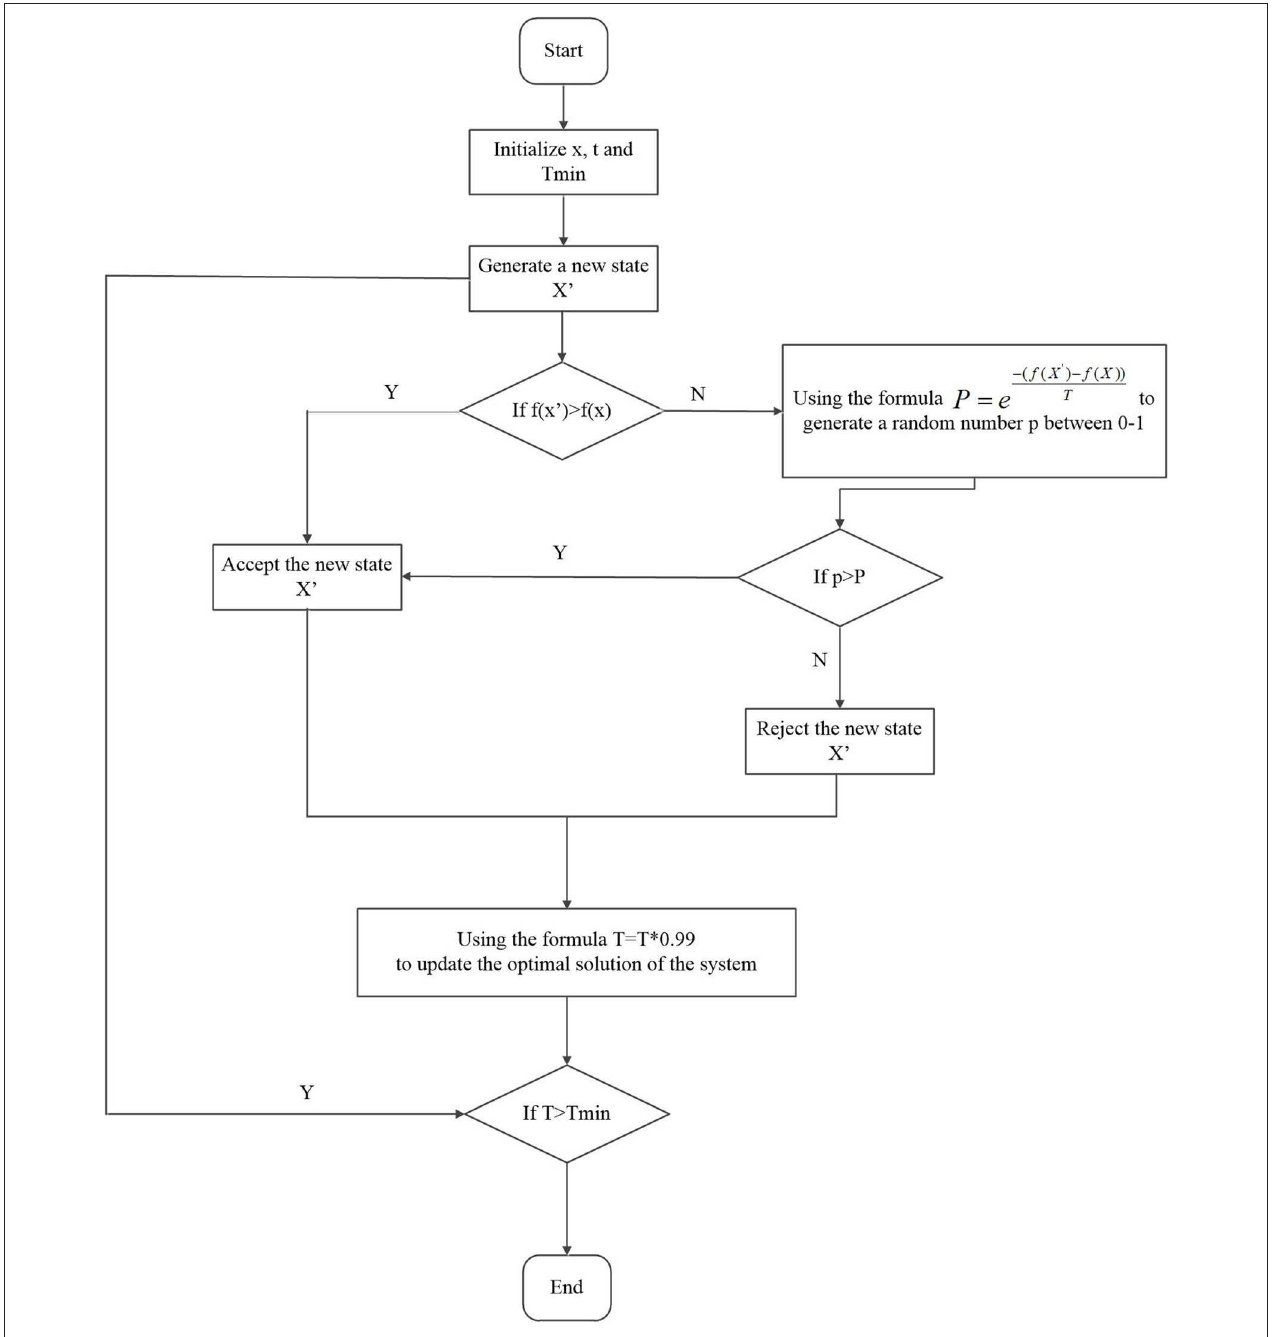
FIGURE 5 | Flow chart of the improved